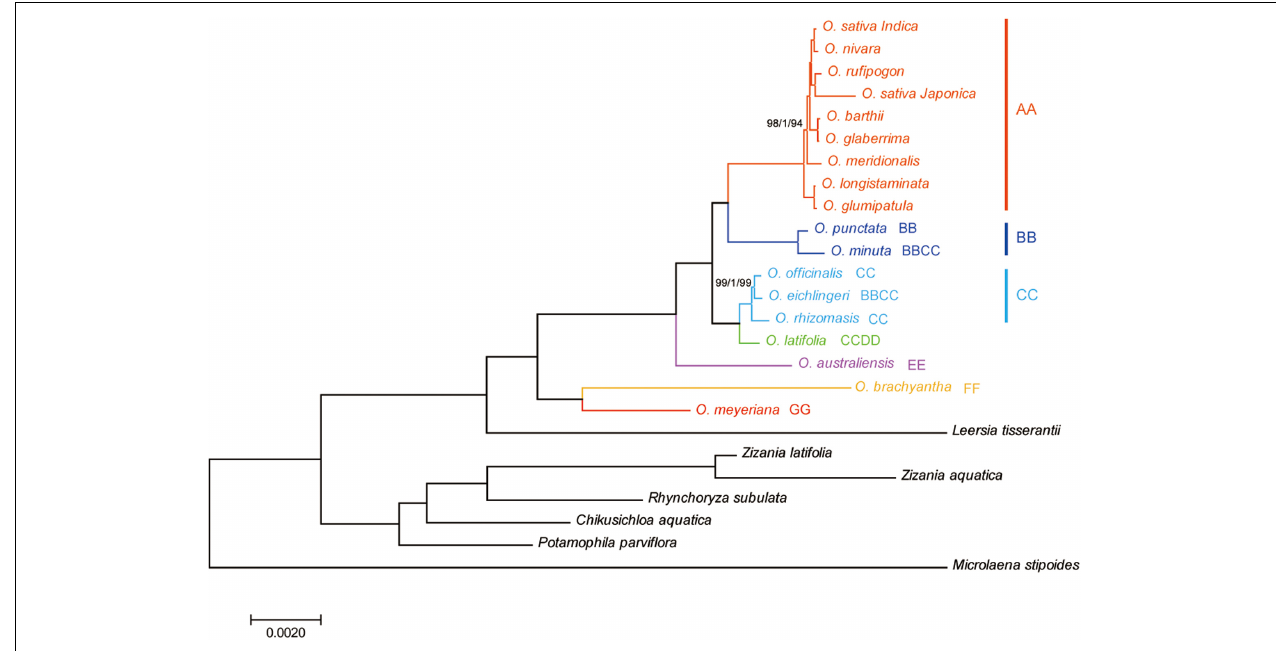
FIGURE 4 | Phylogenetic tree reconstruction of 25 taxa using maximum likelihood, Bayesian inference, and maximum parsimony methods based on the complete chloroplast genome sequences. ML topology shown with ML bootstrap support value/Bayesian posterior probability/MP bootstrap support given at each node. Nodes with 100 ML-BP/1.0 BI-PP/100 MP-BP are not